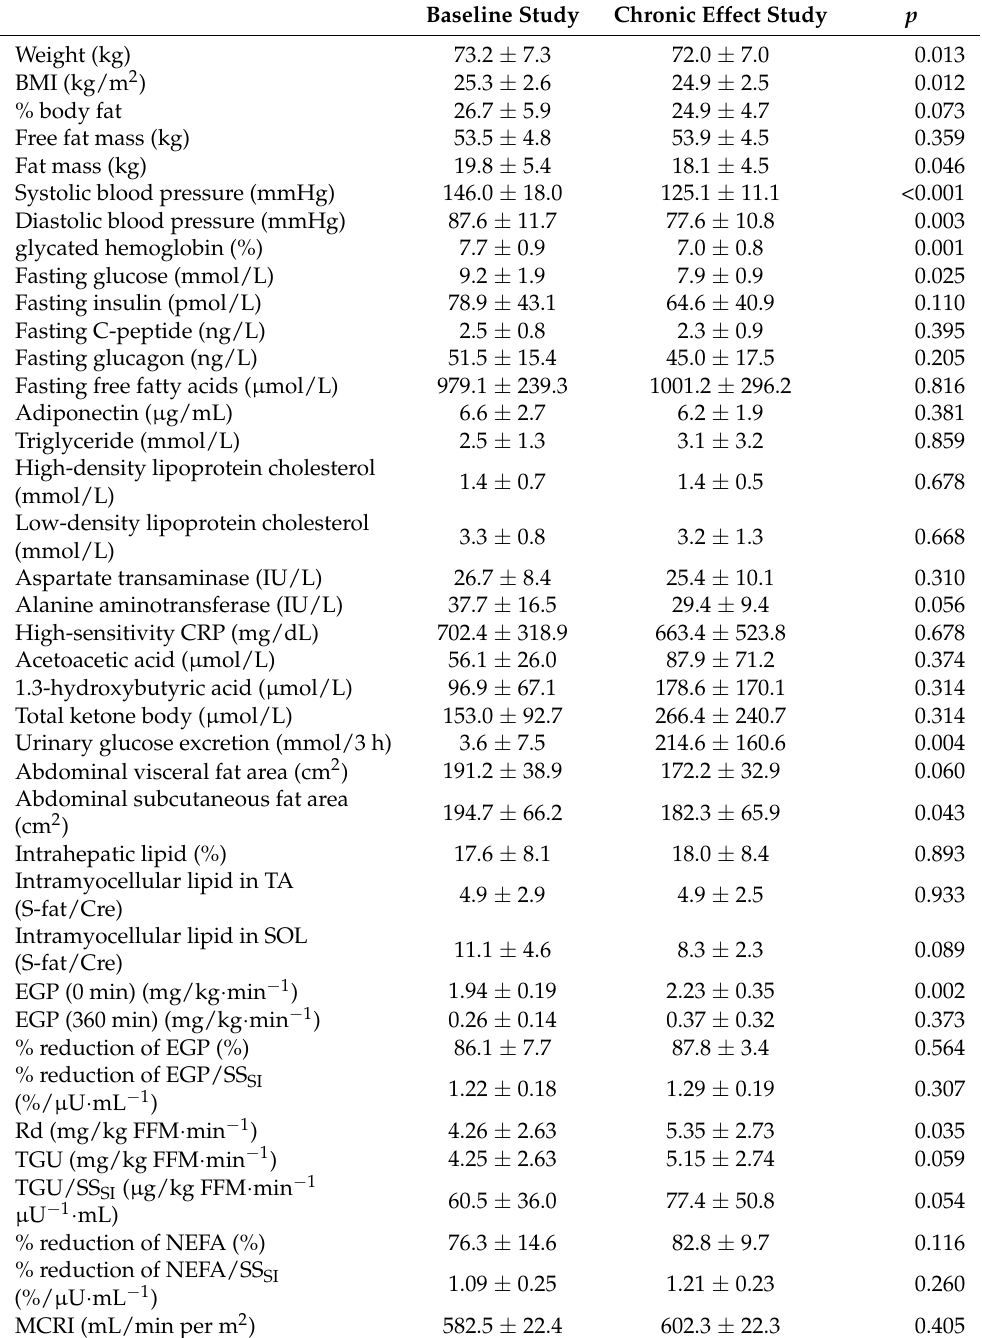
Table 3. Various clinical parameters at baseline and after 8 weeks of tofogliflozin treatment (chronic effect study) ( n =